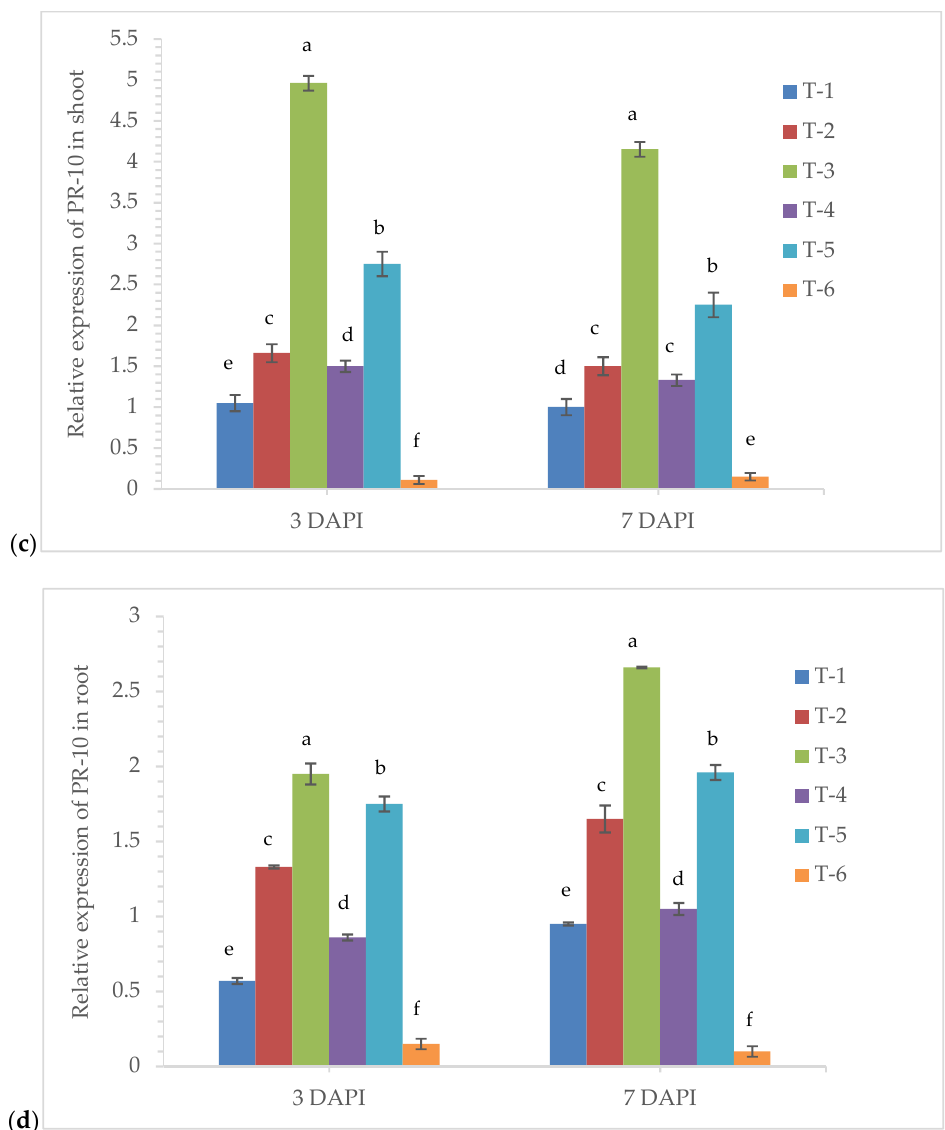
Figure 6. qRT-PCR results showing the time-dependent and tissue-specific differential expression profile of zmPR-1 and zmPR-10 in the maize plants bio-primed with P. aeruginosa MF-30 at 3 and 7 DAPI, ( a ) relative expression of zmPR-1 in shoot, ( b ) relative expression of zmPR-1 in root, ( c ) relative expression of zmPR-10 in shoot, and ( d ) relative expression of zmPR-10 in root. Treatments were: T 1 - plants inoculated with R. solani alone; T 2 - R. solani + seed bio-primed with P. aeruginosa MF-30; T 3 - R. solani + seed bio-primed with P. aeruginosa MF-30 + foliar spray of MF-30; T 4 - R. solani + foliar spray of culture filtrate of MF-30; T 5 - R. solani + seed bio-primed with P. aeruginosa MF-30 + foliar spray of culture filtrate of MF-30; T 6 -Control (untreated). The data represents the relative fold changes in the expression value of the six different treatments. Data are mean ± SEM ( n = 5). 3.7. Epiphytic Colonization of GFP-Tagged P. aeruginosa MF-30 on Maize Leaf Confocal laser microphotographs clearly indicated the epiphytic survival and colonization of P. aeruginosa strain MF-30 on the leaf surface. Results indicated that P. aeruginosa strain MF-30 colonizes on the fungal mycelia and disintegrates the hyphae and infection cushion formed during the infection process and ultimately restricts the disease development (Figure 7).